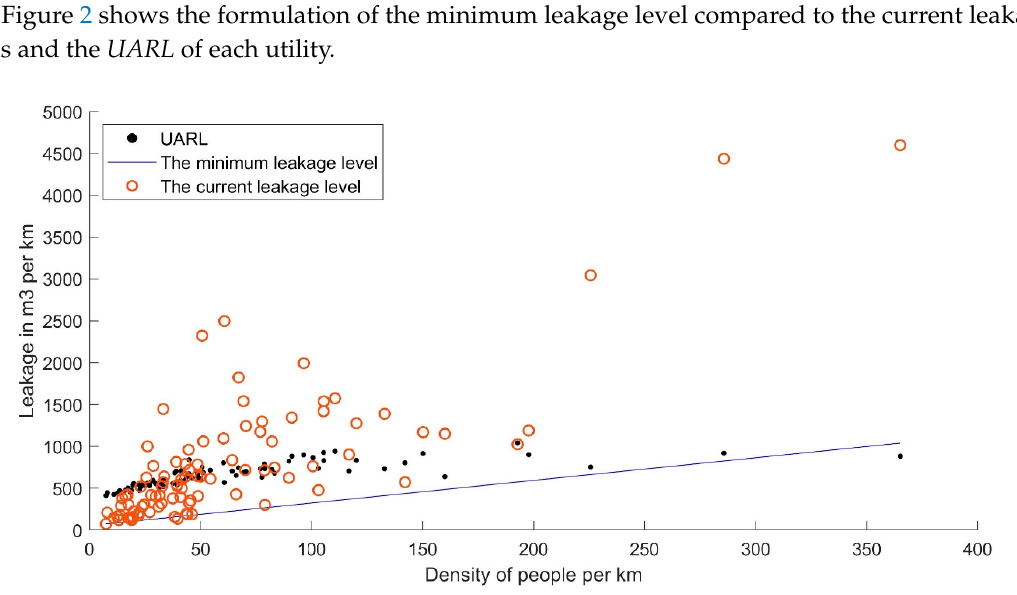
Figure 2. The current leakage level, the minimum leakage level according to the unavoidable annual real losses (UARL) formula, and the devised minimum leakage level in terms of leakage volume in m 3 /km of the Finnish utilities plotted against the density of people per kilometre of network.